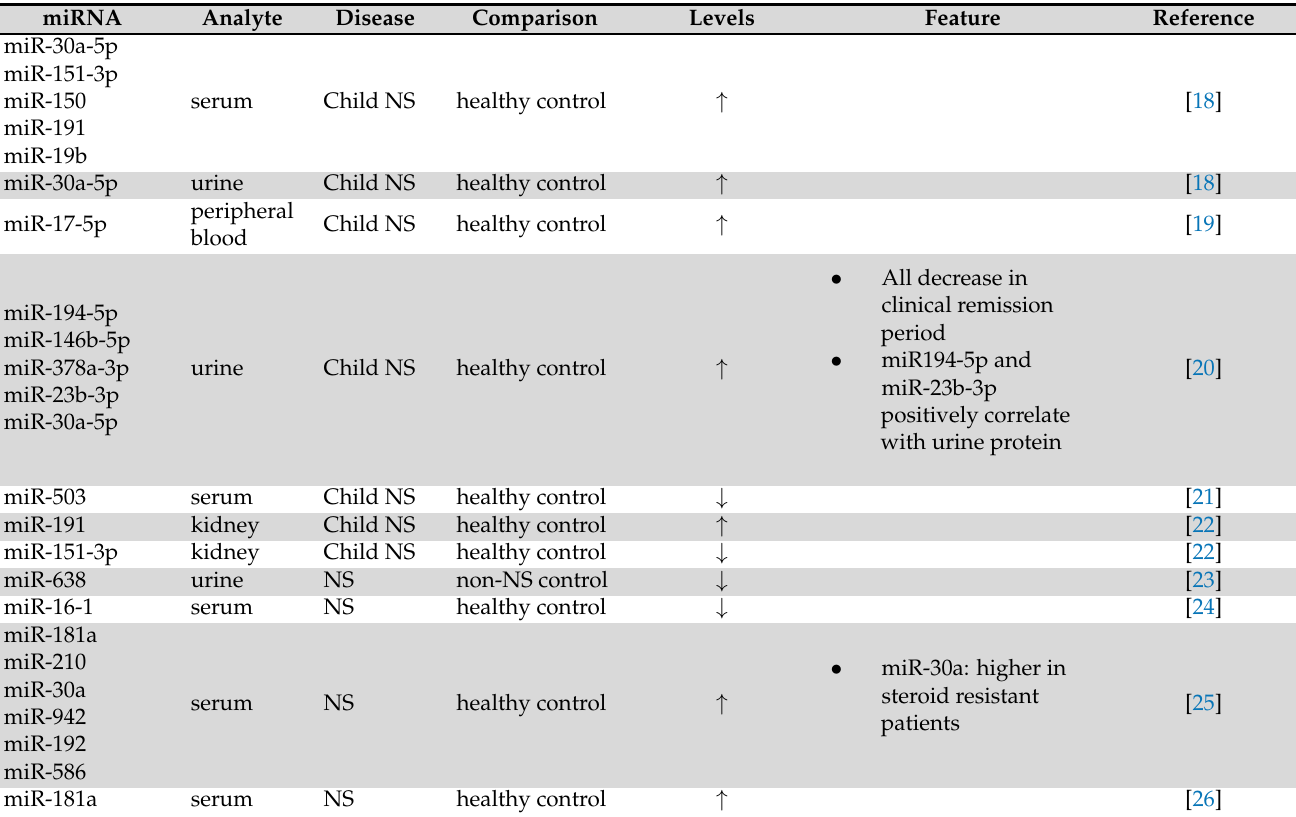
Table 1. MiRNAs in nephrotic